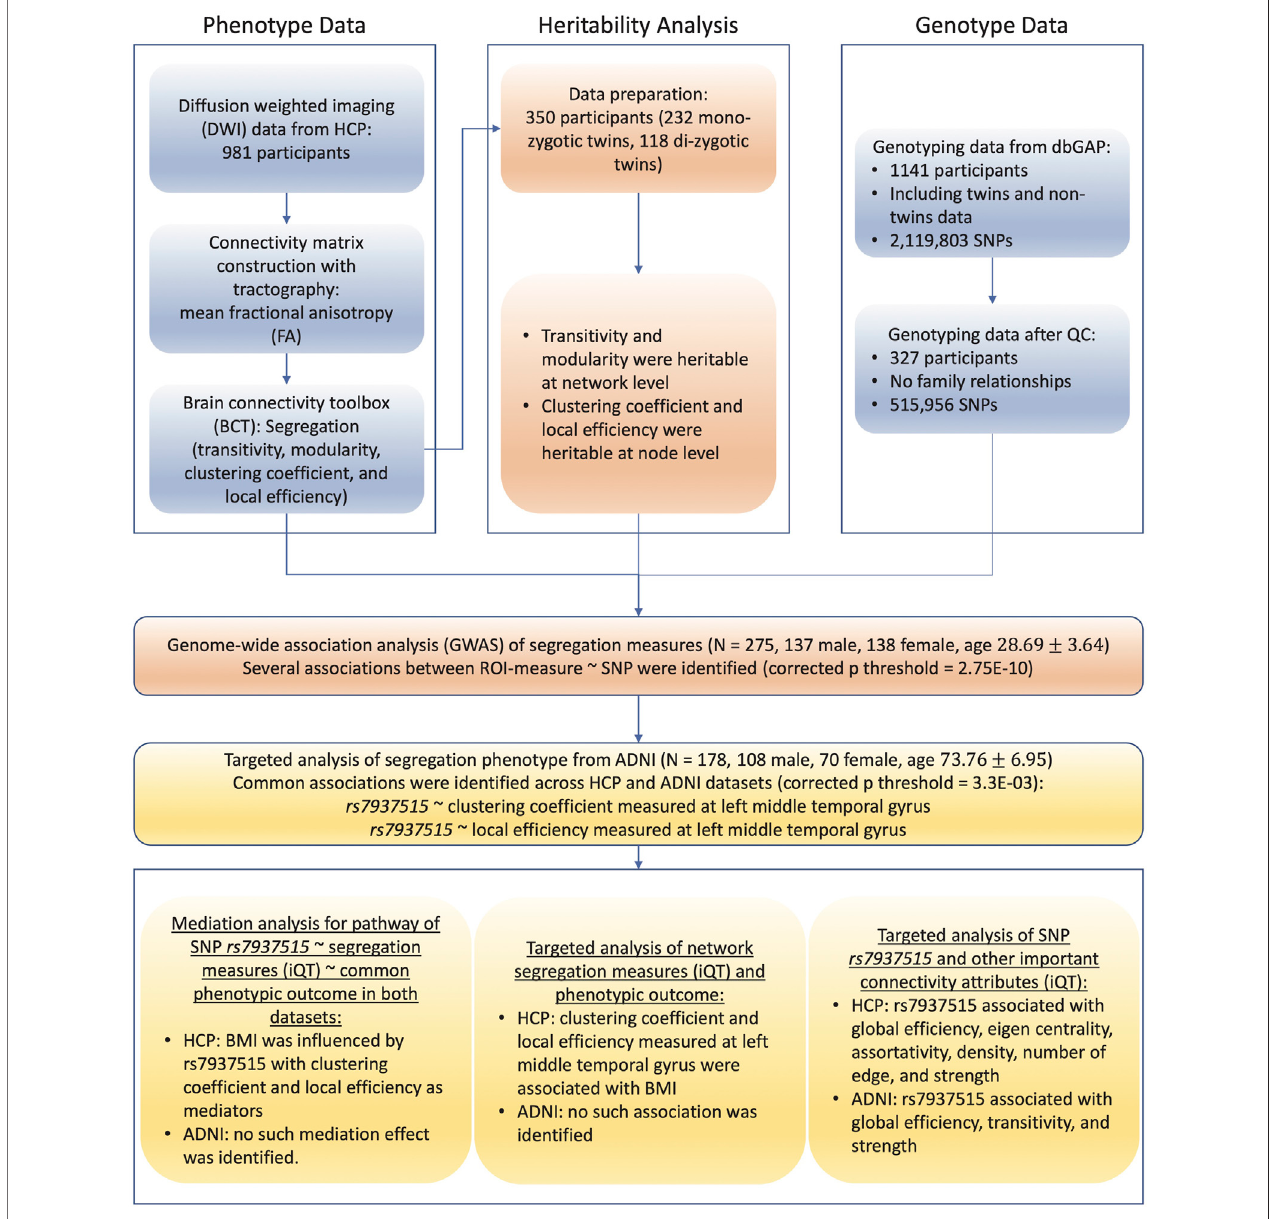
FIGURE 1 | Flowchart of brain connectome GWAS design. Abbreviations: SNPs, single nucleotide polymorphisms; ADNI, Alzheimer ’ s disease neuroimaging initiative; HCP, human connectome project; dbGaP, database of genotypes and phenotypes; QC, quality control; ROI, region of interest; iQT: imaging quantitative trait; BMI, body mass